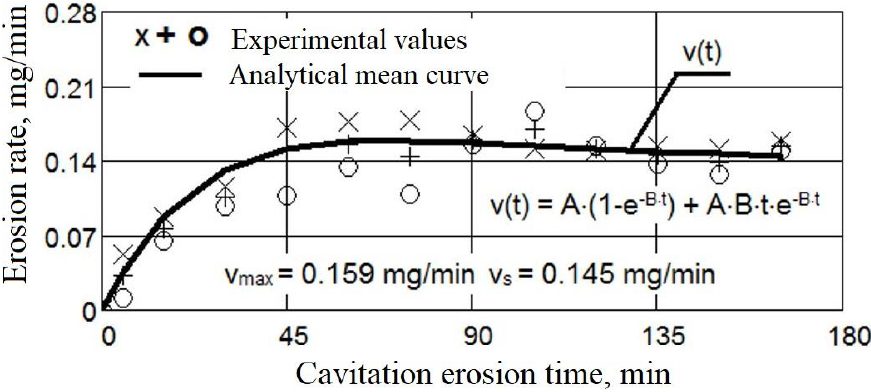
Figure 7. Erosion rate of GX40CrNiSi25-20 steel related to the cavitation time (no remelting).